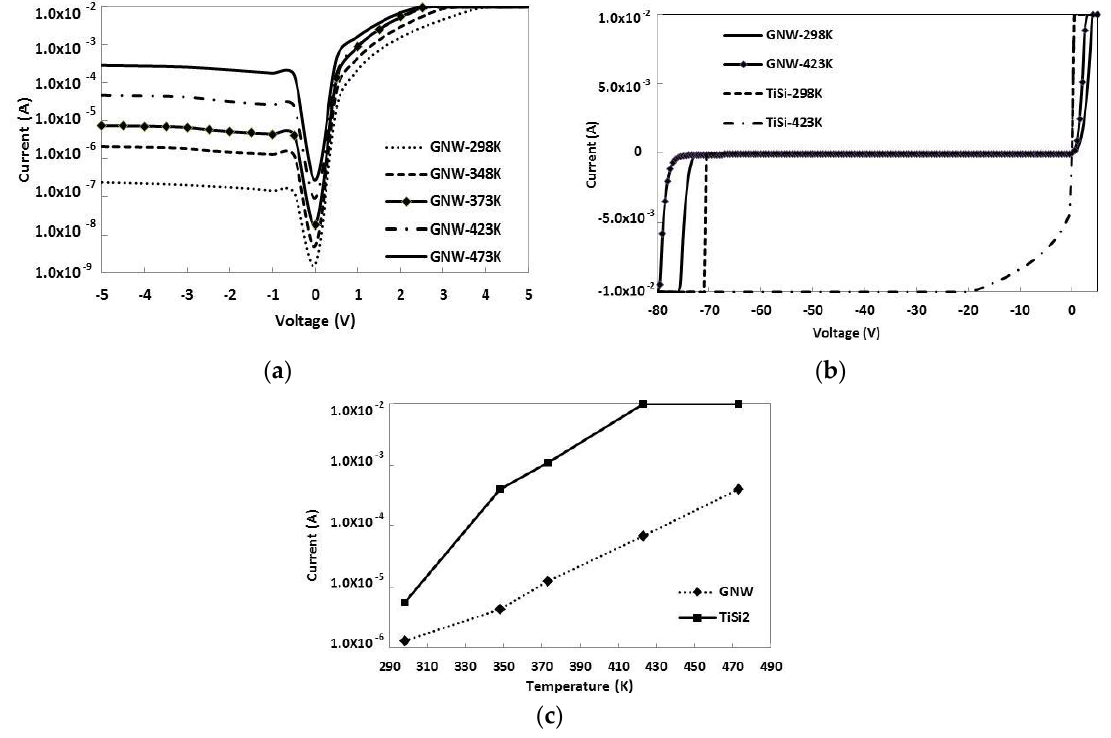
Figure 5. ( a ) Current versus voltage in semilog scale for GNW-TMBS. ( b ) I-V curves of GNW and TiSi 2 diodes showing breakdown voltage. ( c ) Leakage current versus temperature of GNW and TiSi 2 -TMBS diodes at 60 V.